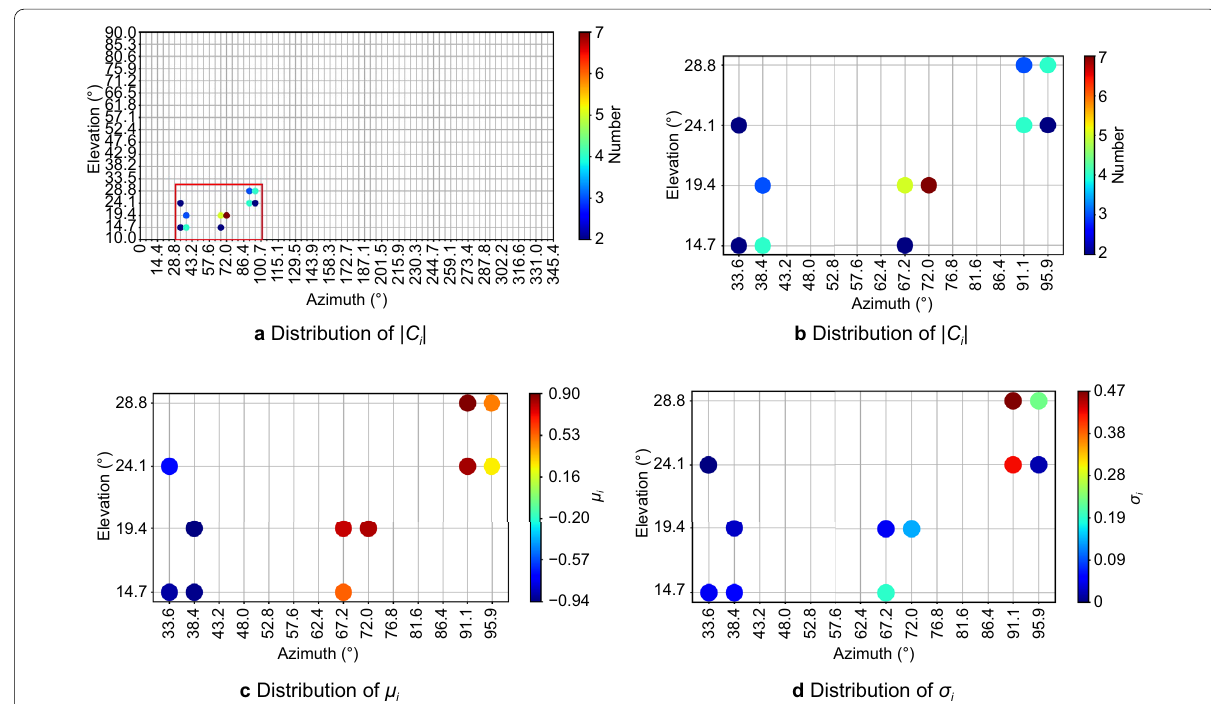
Fig. 7 Distribution of | C i | (the top two sub‑plots), μ i (the left‑bottom sub‑plot), σ i (the right‑bottom sub‑plot) in Eq. (7) against elevation angle and azimuth angle for latitude 65.9° and longitude 42.0° of solution C ( 36 × 24 × 18 × 75 ) on DOY 001,